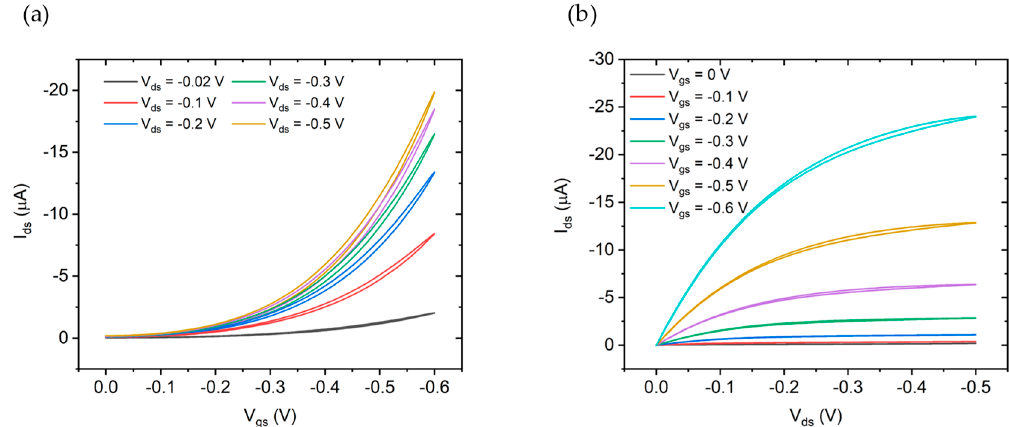
Figure 6. ( a ) Transfer characteristics and ( b ) output characteristics of the Electrolyte Gated Organic Field Effect Transistor (EGOFET) fabricated with no adhesion promoter using P3HT dissolved in oDCB. DI water has been used as a gate electrolyte and an Ag/AgCl leak free reference electrode as a gate electrode.